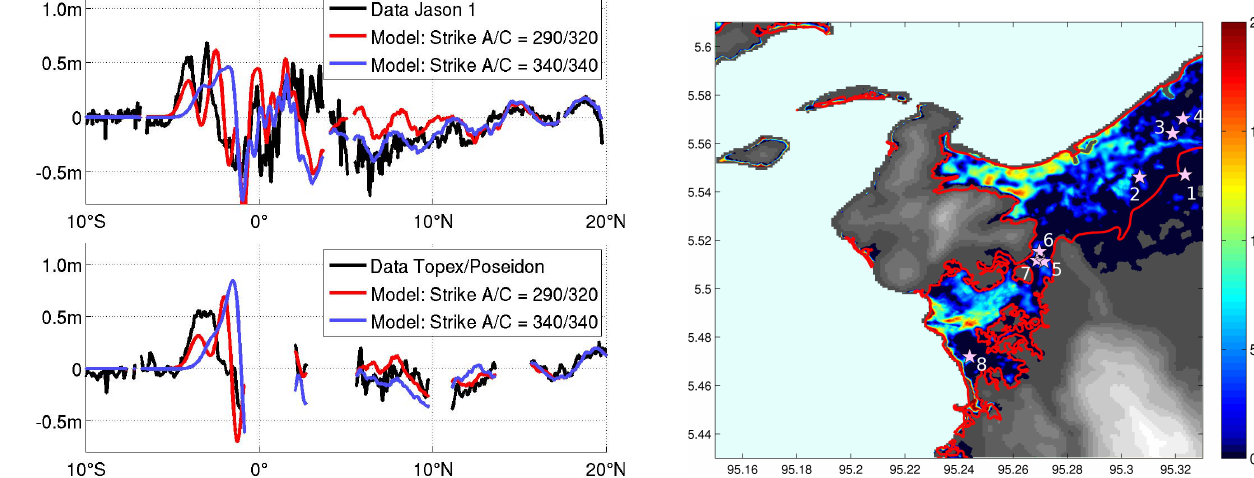
Fig. 7. Tsunami signal extracted from the satellite tracks Jason 1 and Topex/Poseidon, and model results along the tracks interpolated in space and time.